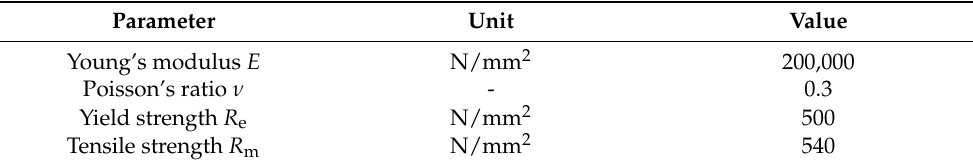
Table 3. Material parameters of B500B implemented in the material model of the FEM simulation.